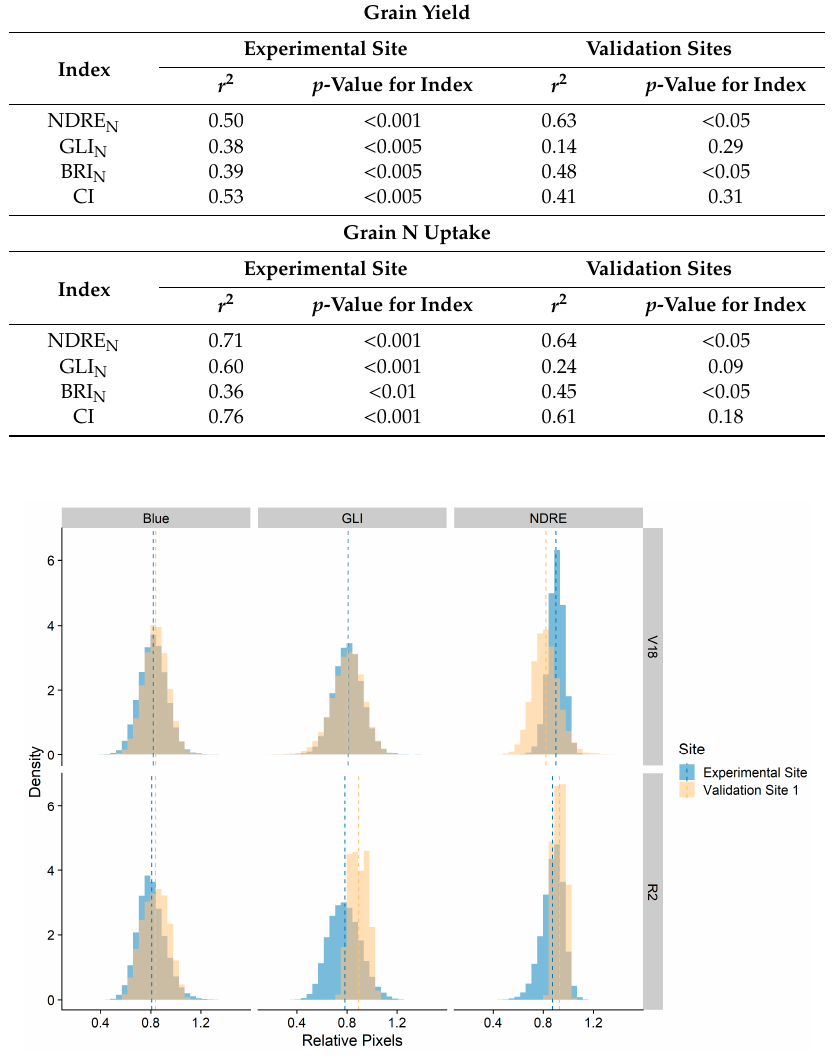
Figure 4. The distribution of relative values for individual pixels of blue, green leaf index (GLI), and the normalized difference red-edge (NDRE) throughout the experimental areas at the experimental site and validation site 1 at both the 18th leaf stage (V18) and blister (R2) growth stages. Individual pixel values are relative to the 95th percentile of the measured index values. Dashed lines show the mean of the pixel values for each